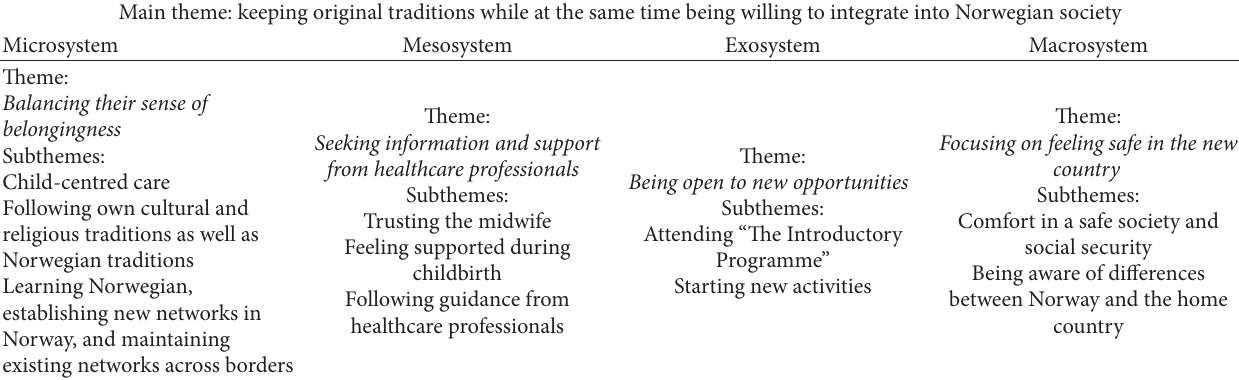
Table 3: Empirical findings and interpretation in the light of ecological theory (Bronfenbrenner 1979 [21]). Main theme: keeping original traditions while at the same time being willing to integrate into Norwegian